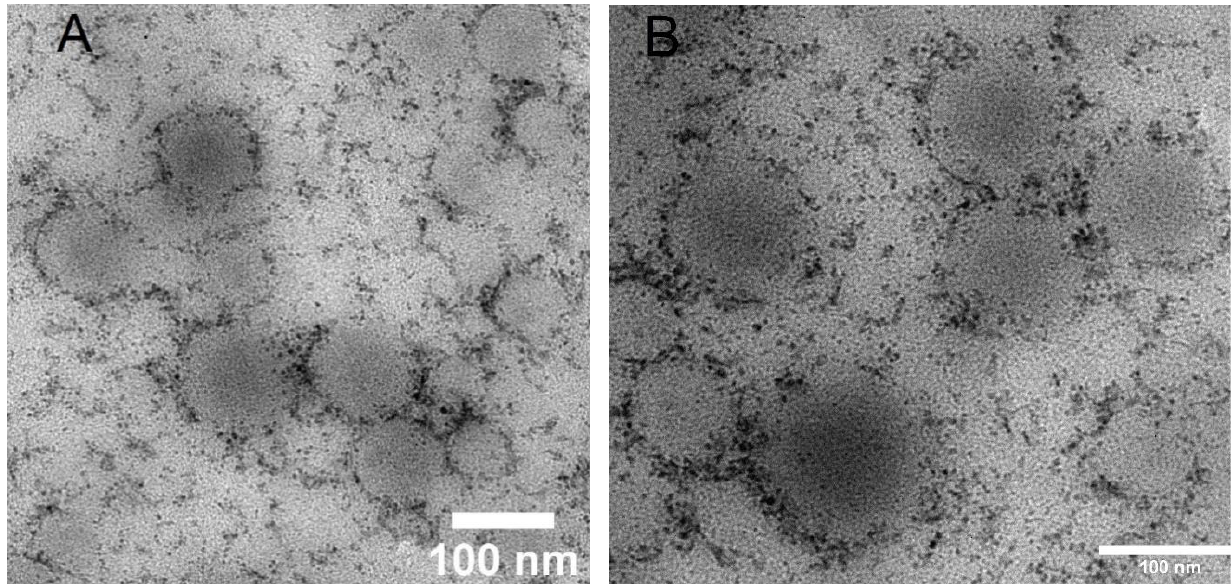
Figure 4. ( A , B ) Hybrid nanoparticles Brij98/Eudragit L100-55/haloperidol after preparation.